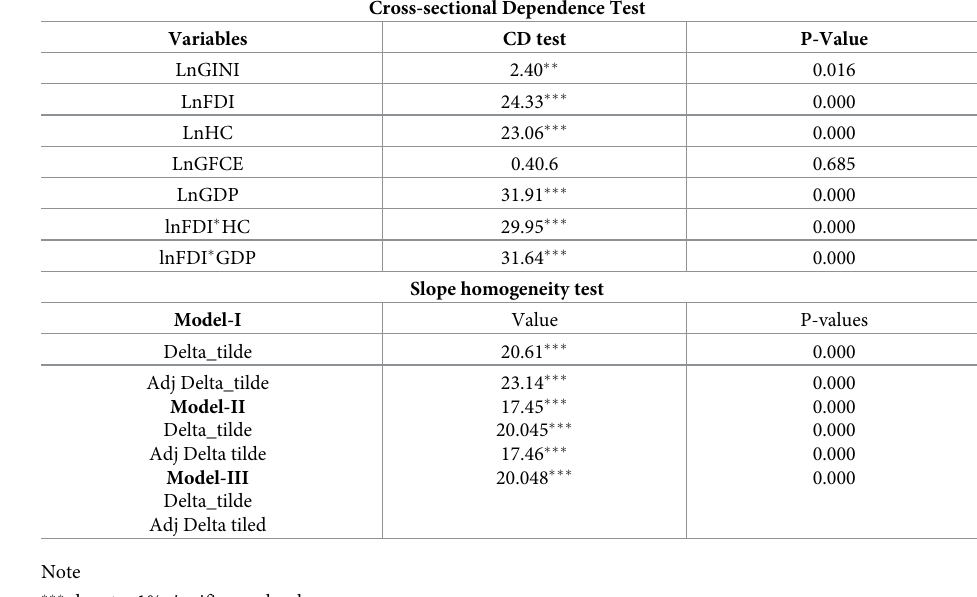
the cross-sectional and panel dependencies suggested by individual common factors. From the Table 3 confirms the existence of mixed orders of stationarity. lnFDI and lnGFCE are station- ary at level with 1% significance, whereas lnGINI, lnHC, lnGDP, lnFDI � HC, and FDI � GDP are stationary in first-difference of order with 1% significance. Therefore, the mixed order of stationarity between the variables recommended the Westerlund co-integration technique and the AMG estimator for estimation. This study analyzed Westerlund’s (2007) co-integration technique to check the long-run equilibrium between income inequality with other independent variables of economic growth, FDI, human capital, government consumption, and especially the distributional effect of inter- results are shown in Table 4. Group mean and panel mean is denoted by G respectively. The analyses confirm a stable long-run association between our interested Table 3. CIPS unit root